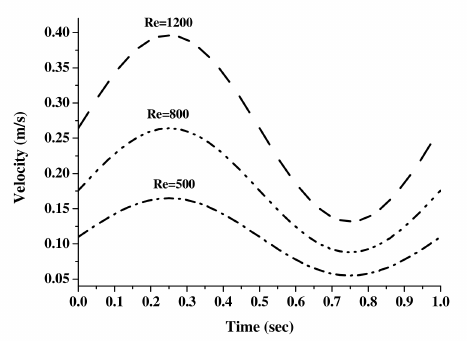
Figure 9. The pulsatile velocity profile at the inlet with the change of Reynolds